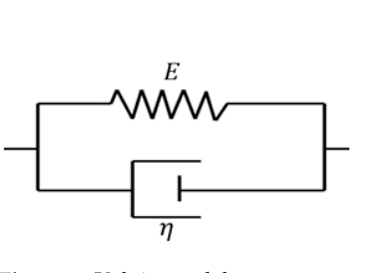
Figure 4. Kelvin model. Figure 4. Kelvin